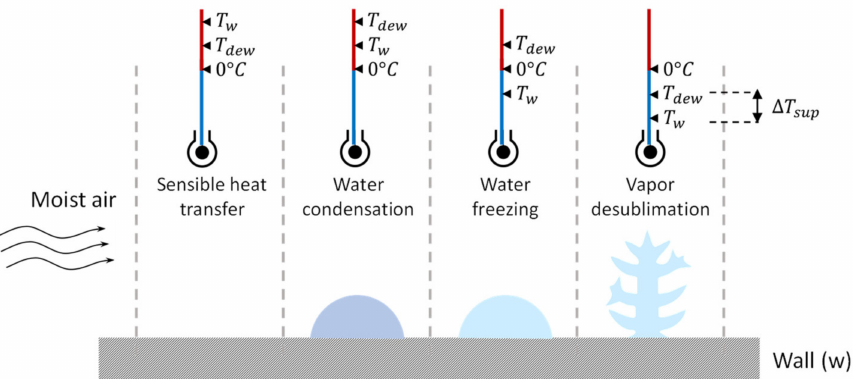
Figure 3. Phase transition of water for different psychrometric and surface conditions.